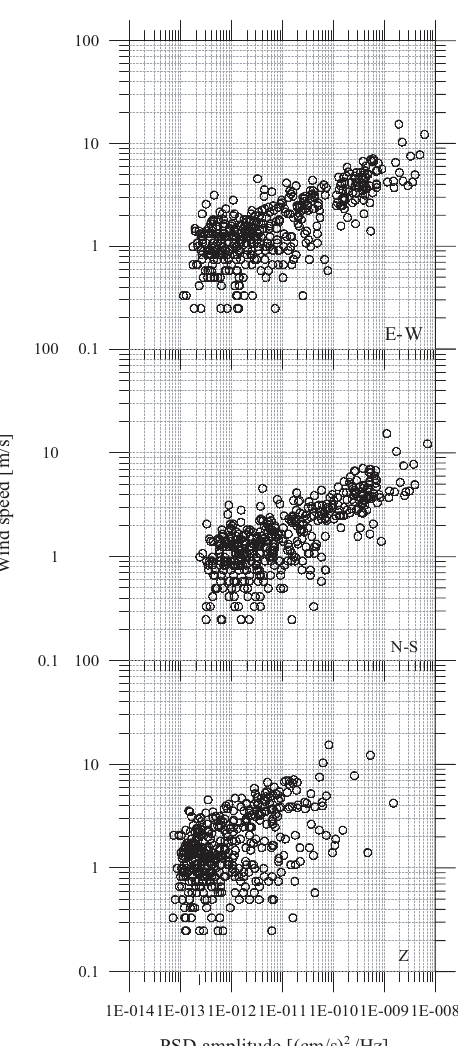
Fig. 5. Variation of the average long period velocity power spectral density amplitude (0.02 < f < 0.03 Hz) with wind speed. Power spectra curves are compared with the high and low noise model according to Aki and Richards